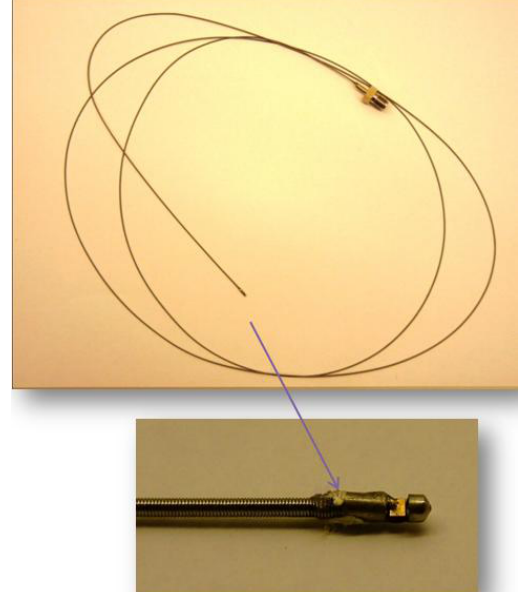
Figure 6. The IVUS transducer based on PMN-PT single crystal